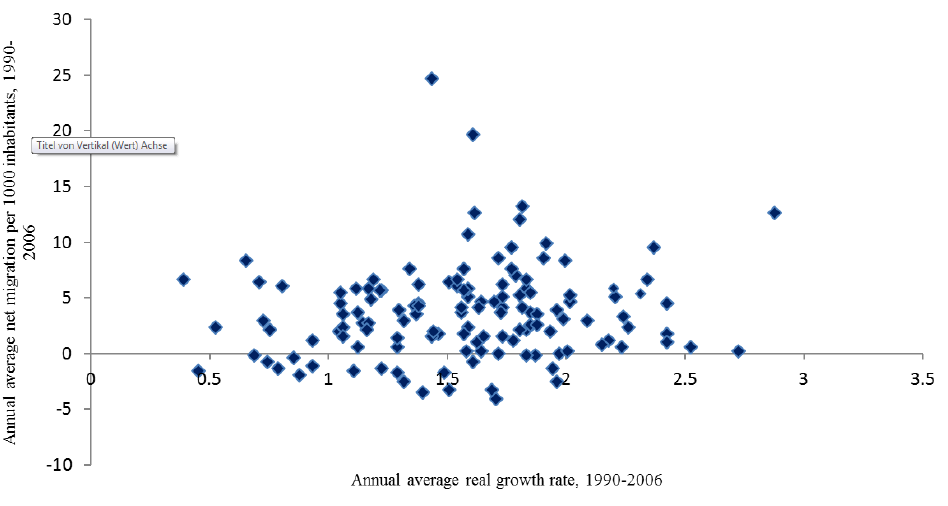
Figure 1: EU-15: Regional growth rate and net migration rate,